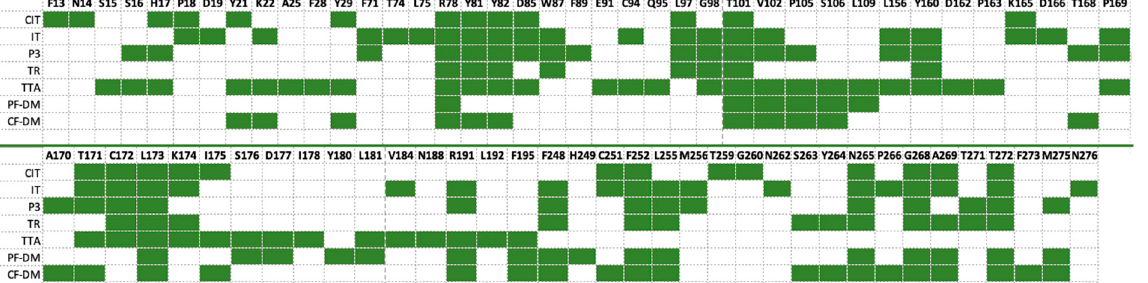
Figure 6. Fingerprint representation for PrankWeb binding site predictions of the models used in this study. Y axis—GPR18 models; X axis—residue with corresponding numbers. Green boxes indicate predicted residue. For a colored figure, please refer to the online version of this paper.